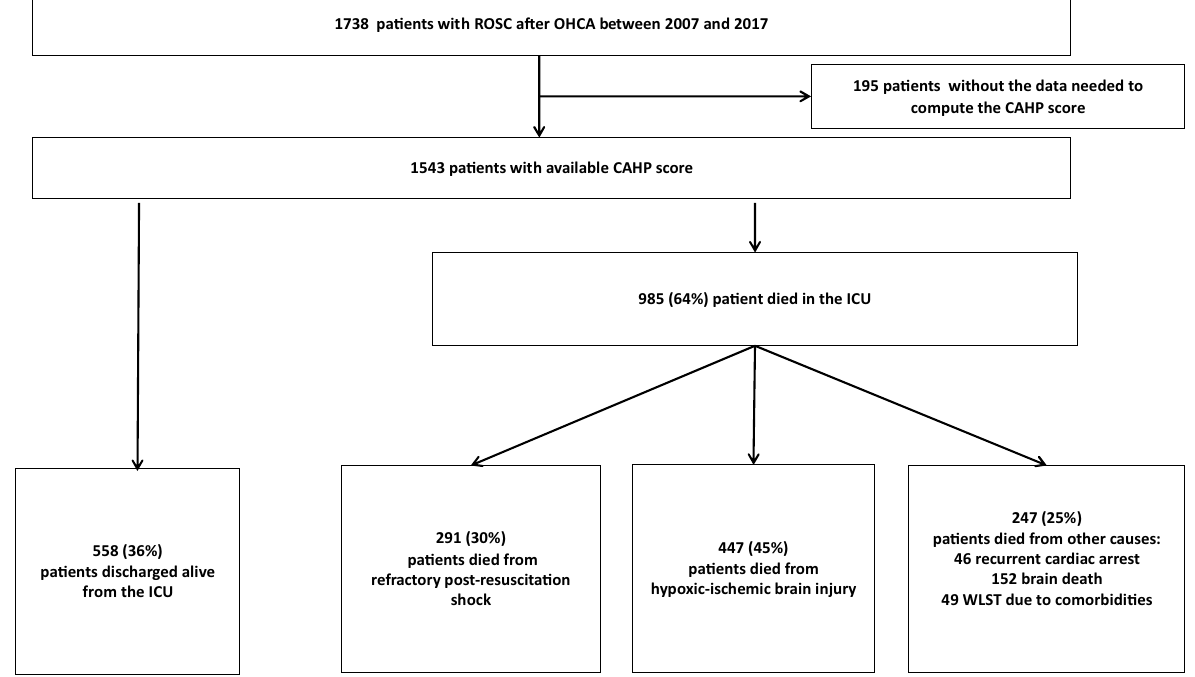
Figure 1. Flow diagram. CAHP cardiac arrest hospital prognosis, ICU intensive care unit, WLST withdrawal of life-sustaining